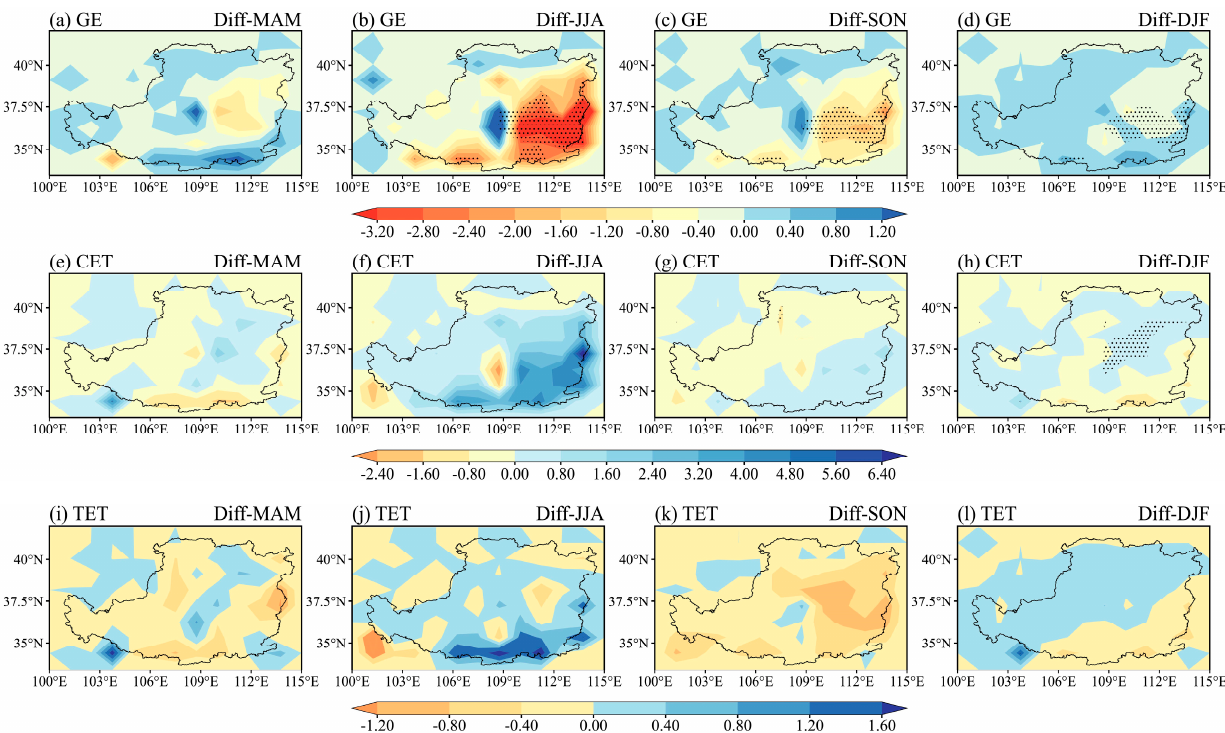
Figure 7. Spatial distributions of the seasonal differences (LC2015 minus C2000) in ET (unit: mm) between LC2000 and LC2015 on the LP. The first column ( a , e , i ), second column ( b , f , j ), third column ( c , g , k ) and fourth column ( d , h , l ) show differences in the ground evaporation, canopy ET, and total ET for spring, summer, autumn, and winter, respectively. MAM, JJA, SOM, and DJF represent spring for the months from March to May, summer for the months from June to August, autumn for the months from September to November, and winter for the months from December to February of the following year, respectively.